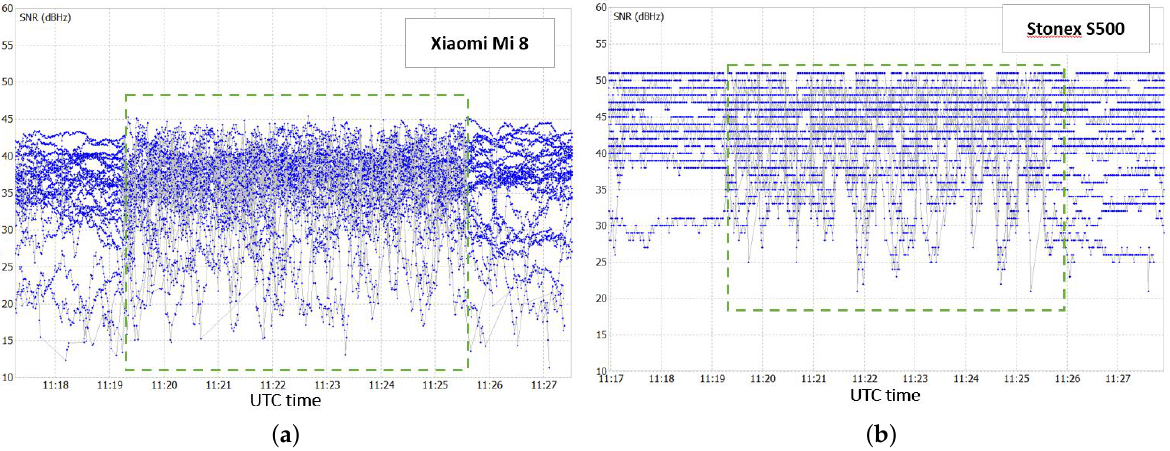
Figure 3. SNR for Xiaomi Mi 8 receiver ( a ) and for Stonex S500 receiver ( b ).